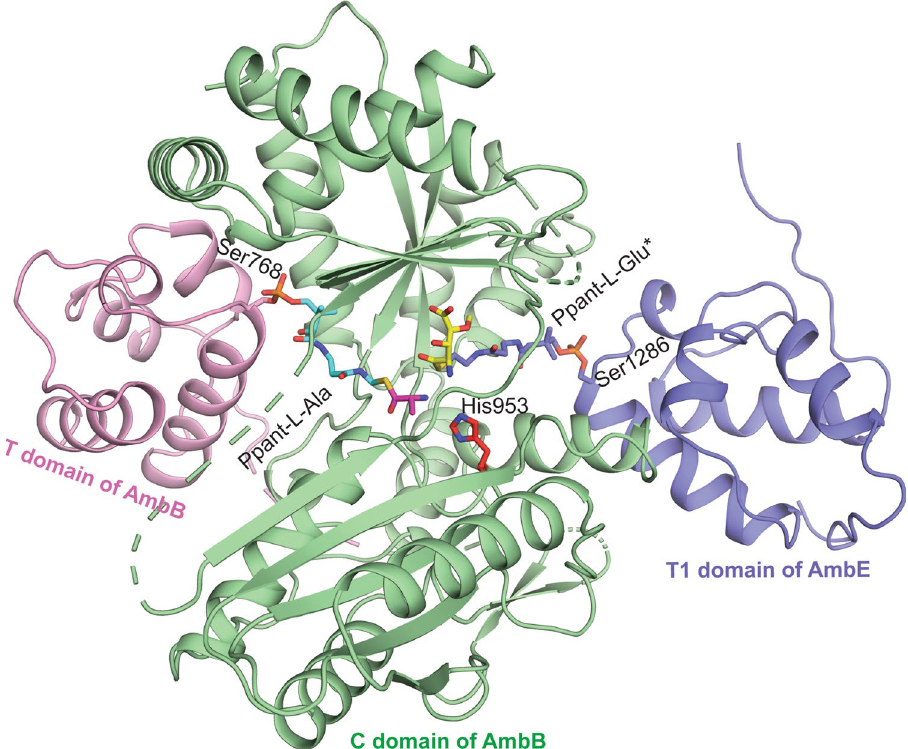
Figure 6. Model of the condensation complex formed by T–C bidomain of AmbB and T1 domain of AmbE. T domain of AmbB is on the donor side of its C domain while the T1 domain of AmbE is on the acceptor side. The amino acid substrates, l-Ala and l-Glu* (hydroxylated and O-methylated l-Glu) are attached to the Ppant arm of the respective T domains. The condensation complex brings the two amino acid substrates within the vicinity of the active site residue His953 and are poised for catalysis. The T1 domain of AmbE is shown in purple with bound Ppant-l-Glu* in purple stick. The coloring scheme of holo AmbB T–C with l-Ala tethered to the Ppant is as in Fig.